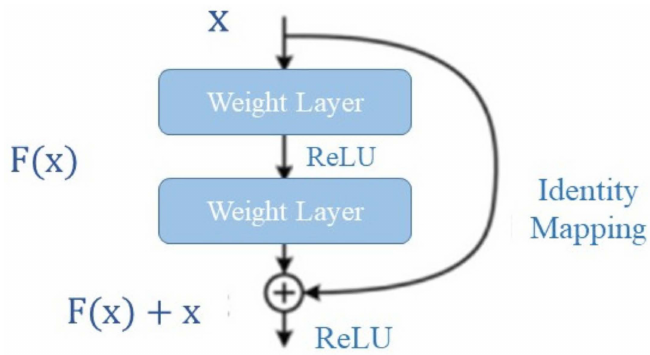
Figure 2. Illustration of ResNet101’s identity mapping.